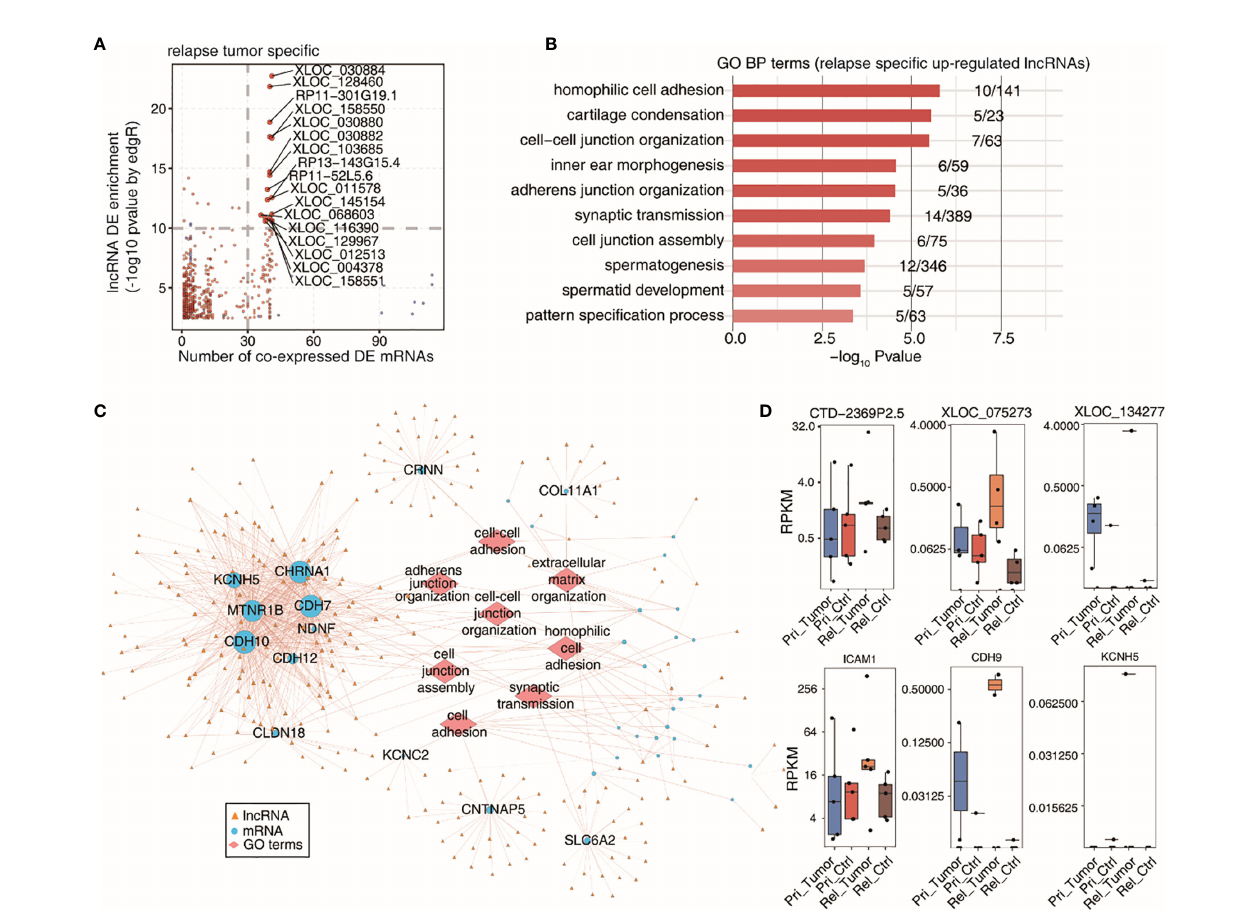
FIGURE 4 | Co-expression network illustration between DElncRNAs and DEmRNAs. (A) Scatter plot showing speci fi c DE lncRNAs by relapse tumor samples and its number of co-expressed DE mRNAs. Red points denote up-regulted lncRNAs involved in co-expression pairs and blue points denote down-regulated lncRNAs. (B) Top 10 most enriched GO terms (biological process) by DE mRNAs co-expressed with the speci fi c up-regulted lncRNAs in relapse tumor samples. (C) The co- expression network between speci fi c up-regulated lncRNAs by relapse tumor samples and co-expressed DE mRNAs which are involved in terms related to cancer metastasis. LncRNAs are represented in yellow triangle and co-expressed mRNAs are represented in blue circle and the mRNA-enriched GO terms are represented in red diamond. (D) Boxplots showing expression status of 3 DE lncRNAs and co-expressed mRNAs which were speci fi c up-regulated in relapsed